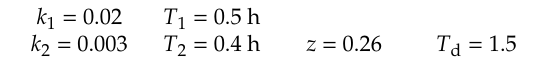
Table 3. Parameters of the supplementary linear input / output mathematical model, which describes the influence of stirrer speed on the CO 2 release of the analysed fermentation process in a batch bioreactor. k 1 = 0.02 T 1 = 0.5 h